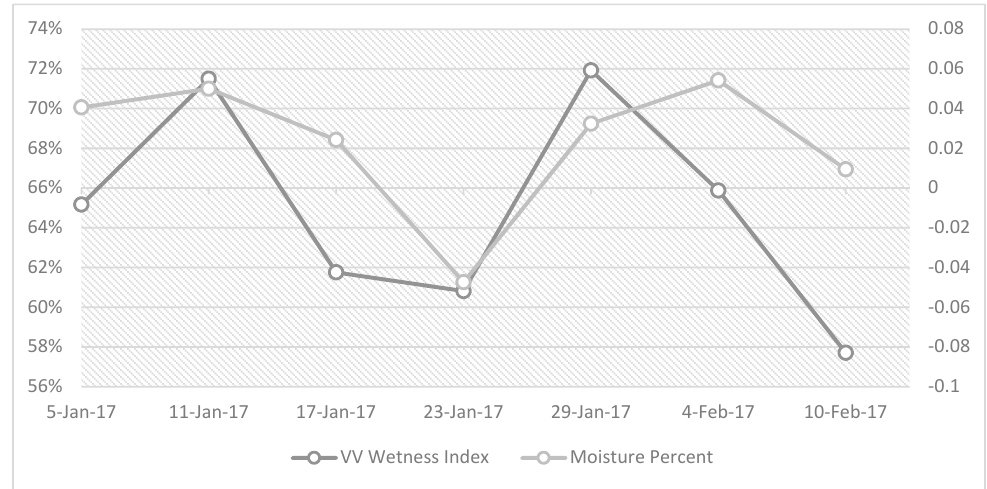
Figure 5. Plot 5 soil water content variability. The following readings from Test Plot 5 in An Giang province, in which the farmer uses flooded management practices, shows the VV WI and moisture percent readings for the plot. The two factors show a strong correlation (r = 0.59)